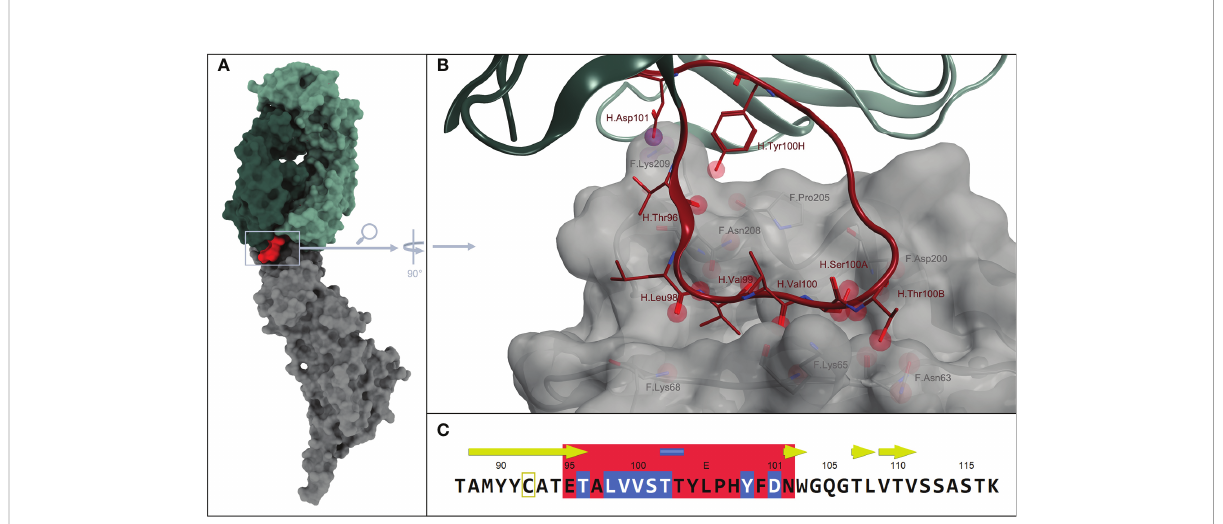
FIGURE 1 (A) Overall structure from PDB ID: 4JHW. Surface colors of D25 antigen-binding fragment heavy chain, in dark green + CDR H3 in red. D25 light chain in light green and fusion glycoprotein F in gray.; (B) Magni fi cation on interaction sites between D25-antibody and fusion protein, which is additionally displayed with a grayish, transparent surface. Spheres embody possible interaction points between residues of the antibody and the antigen. More speci fi cally, red spheres describe possible H-bonds and purple spheres describe possible ionic interactions, between the residues of CDR H3 loop and the fusion protein. The color scheme corresponds to that in A, meaning, CDR H3 is colored in red, whereas the remaining areas of the antibody are shown in light and dark green. The fusion glycoprotein F is colored in gray (C) illustrates the section of the corresponding sequence with the CDR H3 part, also in red. Amino acids with obvious interactions are highlighted in